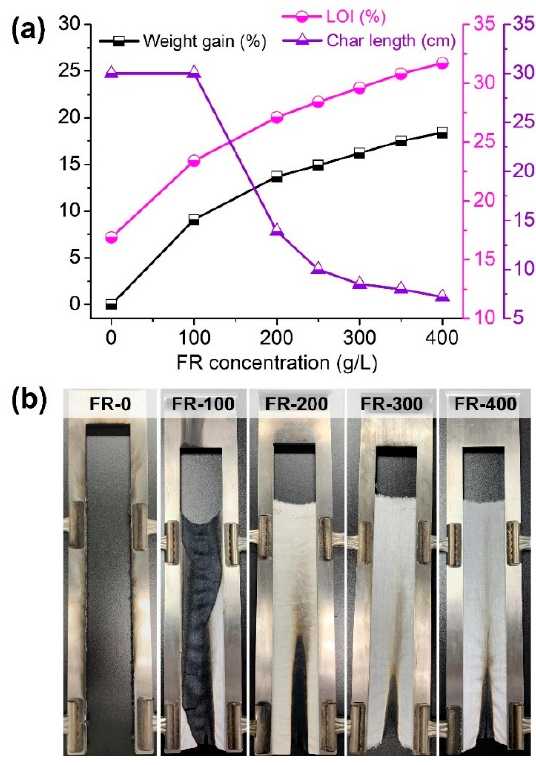
Figure 6. Weight gain and flame retardancy of the coated T/C blend fabrics ( a ) and the corresponding photos after vertical burning test ( b ).